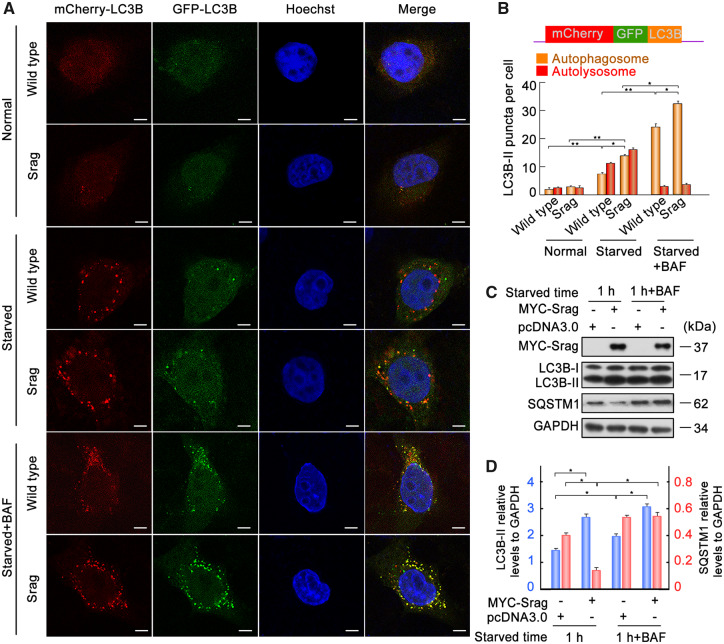
Srag-associated autophagy flux. (A) srag overexpressed and wild-type HeLa cells were transfected with the mCherry-GFP-LC3B tandem reporter. The cells were cultured in normal (control), EBSS medium (1 h), or EBSS with bafilomycin A1 (100 nM) addition (1 h), respectively. Single channel (red, green, or blue) and merged images were taken by confocal microscopy. (B) Statistic analysis of vesicles positive for both GFP and mCherry (autophagosomes) and for mCherry (autolysosomes) (>15 cells per experiment). Colocalized dots were counted. Data are presented as means ± SD. *P < 0.05, **P < 0.01 (n = 3 independent experiments). (C, D) srag overexpression promoted LC3B-II formation. Bafilomycin A1 treatment resulted in protein accumulation of LC3B-II. srag overexpression and control HEK293T cells were cultured and then starved in EBSS with or without bafilomycin A1 (100 nM) for 1 h. The cell lysates were analyzed by immunoblotting with the anti-LC3B, anti-SQSTM1, and anti-MYC antibodies. GAPDH was used as an internal control. (D) Western blots were quantified for LC3B-II/GAPDH and SQSTM1/GAPDH ratio. Data are presented as means ± SD. One-way ANOVA was performed, *P < 0.05; **P < 0.01 (n = 3 independent experiments).